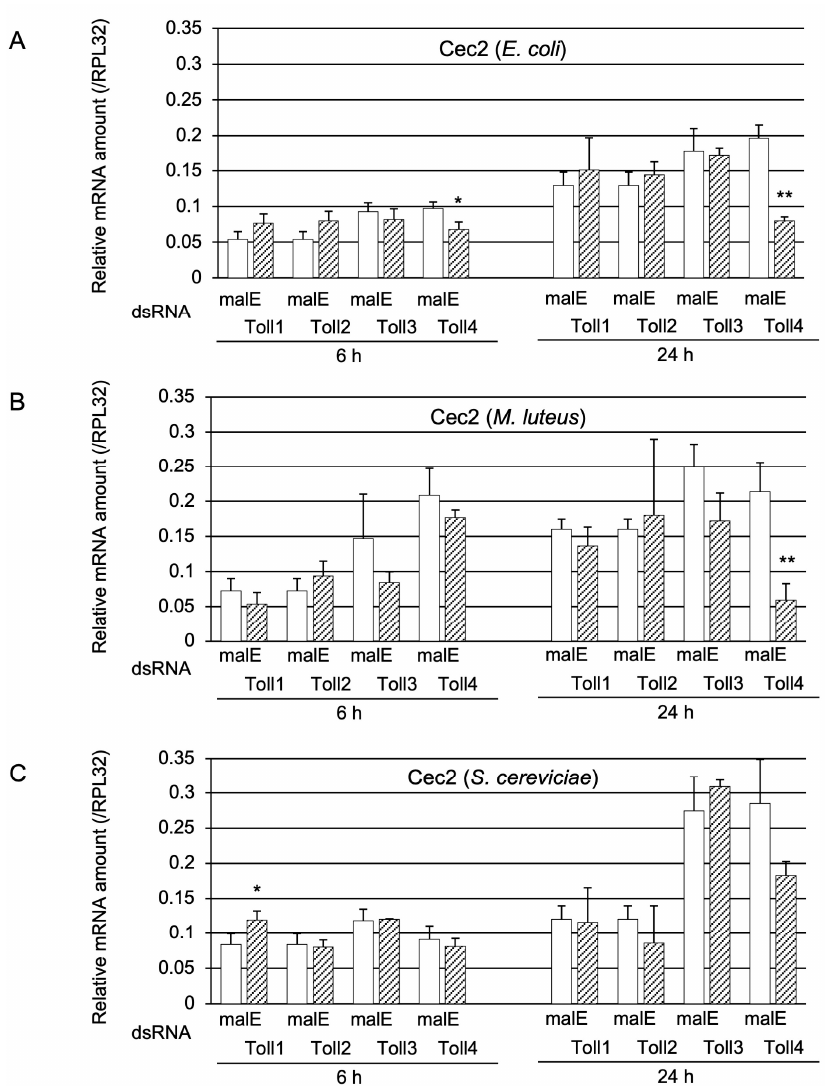
Figure 3. Effect of Toll knockdown on Cec2 induction. mRNA amount of Cec2 in pupae pre-treated with either malE dsRNA (open bars, control) or Toll1 , Toll2 , Toll3 , or Toll4 dsRNA (shaded bars) after challenge with either ( A ) E. coli (Ec), ( B ) M. luteus (Ml), or ( C ) S. cerevisiae (Sc). Day-3 pupae were challenged with heat-killed Ec, Ml, or Sc. The relative mRNA levels of Cec2 in the pupae at 6 or 24 h post injection were measured. The mRNA levels of the genes are shown as relative values to RPL32 levels in the same samples. Experiments involving three animals were independently repeated three times, and each column represents the mean ± S.D. Asterisks and double-asterisks indicate p < 0.05 and p < 0.01 compared to Uc samples, respectively, according to Student’s t